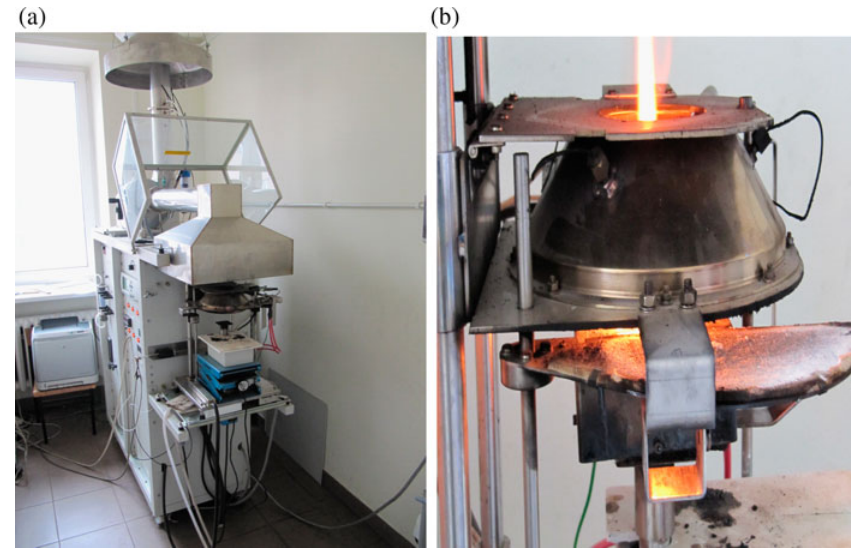
Fig. 1. General view of the cone calorimeter (a) and a burner with the sample after piloted ignition